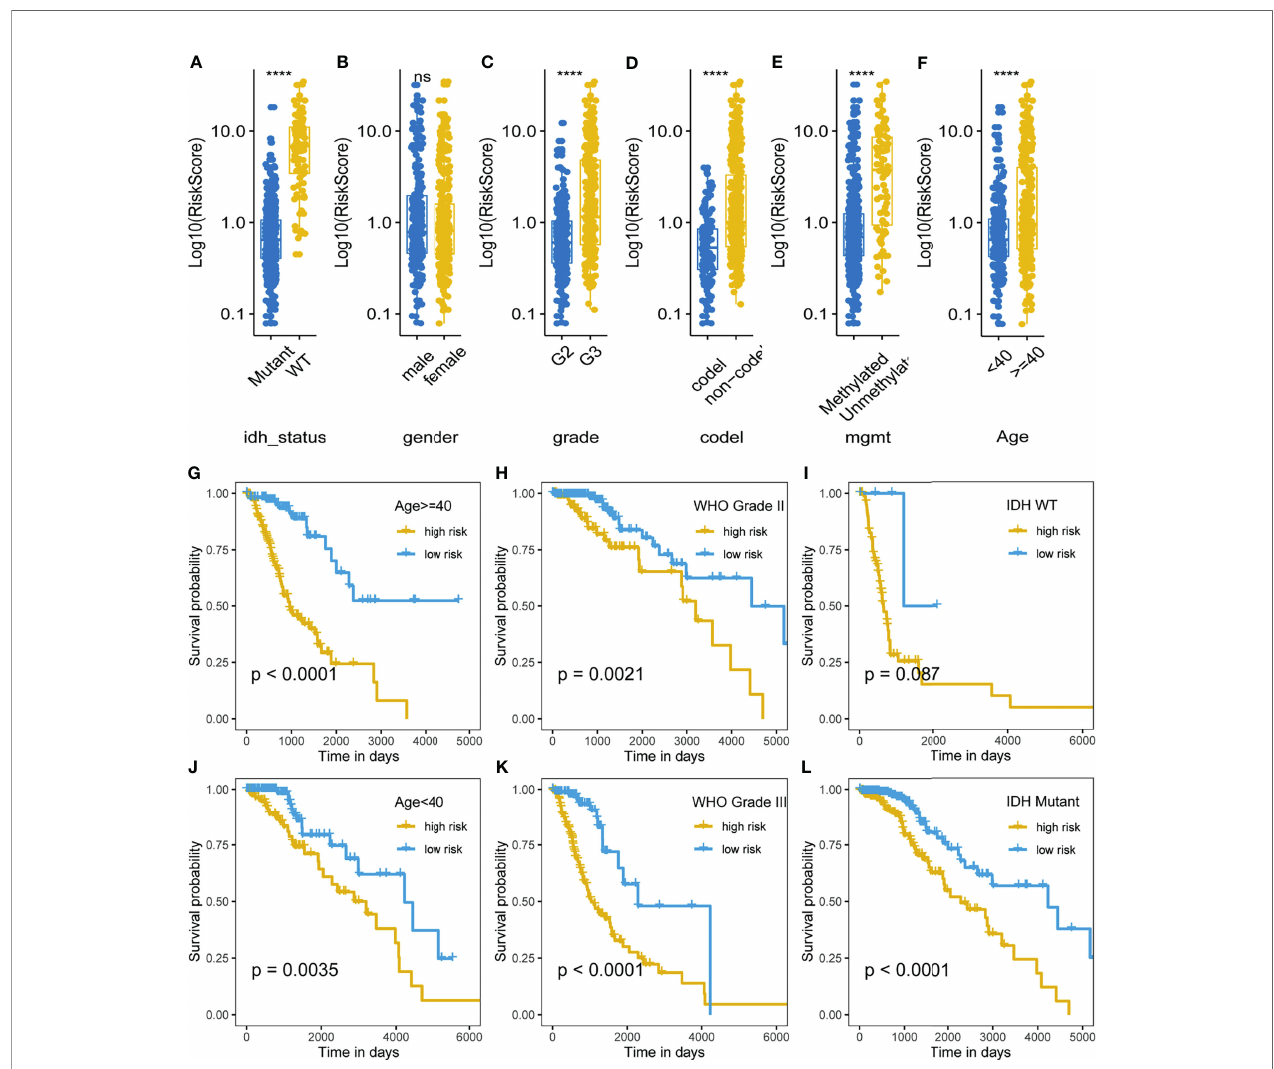
FIGURE 4 | Correlation and prognostic performance of the m5C LPS. (A – F) Different risk scores between patients grouped by clinicopathological features including IDH mutation status, 1p/19q codeletion status, MGMT methylation status, WHO grade, age and gender. (G – L) Kaplan-Meier curves showing stable performance of the signature in differential subgroups of LGG patients including age, WHO grade, and IDH status. ****p<0.0001, ns, no signi fi